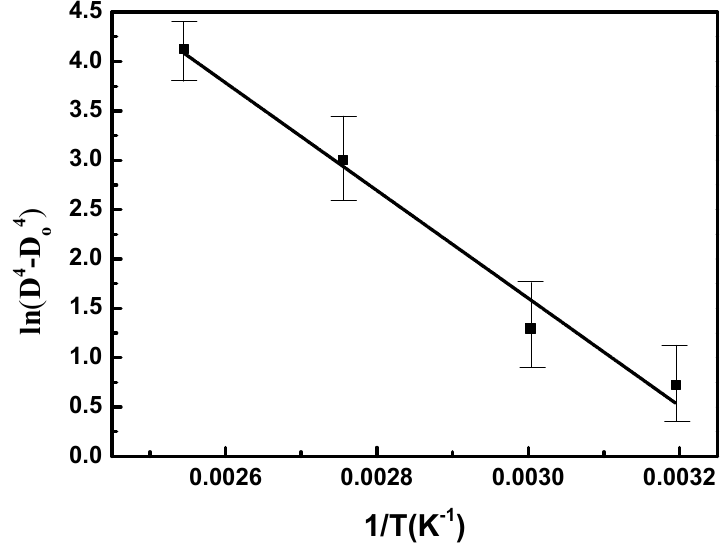
Figure 8. ln( D 4 − D o 4 ) versus 1/ T during Pb-rich phase coarsening. Slope of solid line reveals an activation energy of Q = 45.53 ± 4.23 kJ/mol.